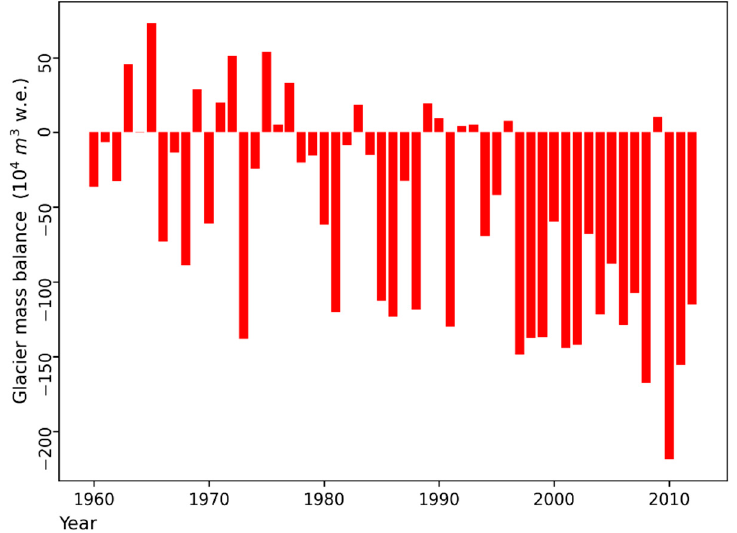
Figure 4. Mass balance of the Glacier No.1 in the Urumqi River basin.